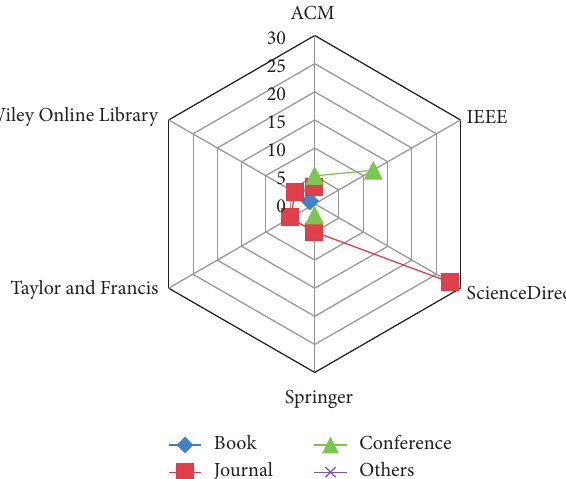
Figure 18: Type of publications along with the number of papers in the given libraries.